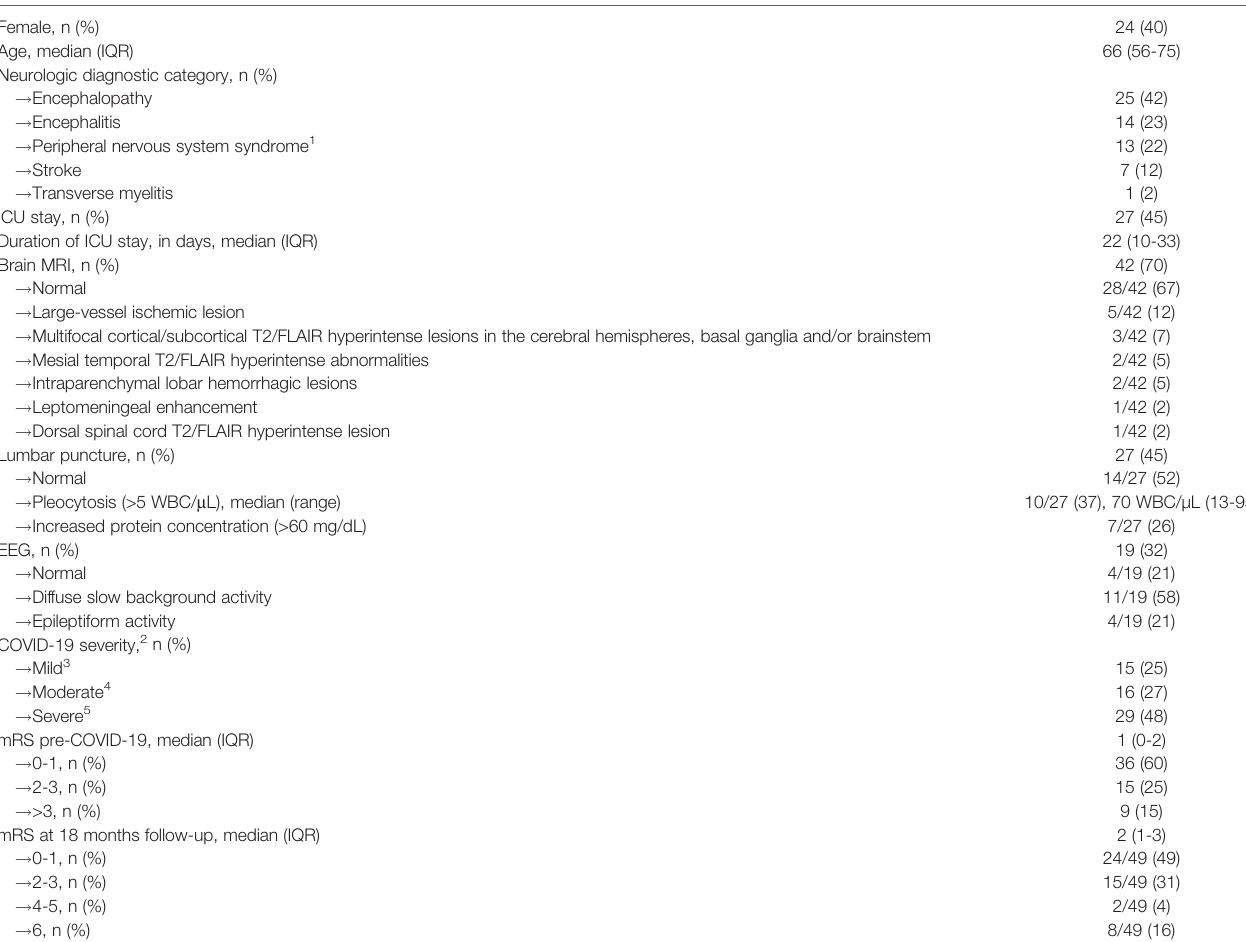
EEG, electroencephalogram; FLAIR, Fluid-attenuated inversion recovery weighted MRI sequences; ICU, intensive care unit; IQR, interquartile range; MRI, magnetic resonance imaging; mRS,modi fi edRankinScale;WBC,whitebloodcells.(1)Criticalcaremyopathy,11(18%);Peripheralnervesyndrome,2(3%).(2)Accordingtotherespiratorystatus.(3)Patientswithnon- ormildpneumoniaorsystemicdisease,andwithoutsupplementaryoxygenrequirements.(4)Patientswithhypoxemiarequiringnon-invasivesupplementaryoxygen.(5)Criticallyillpatients in respiratory failure requiring assisted ventilation, septic shock and/or multi-organ